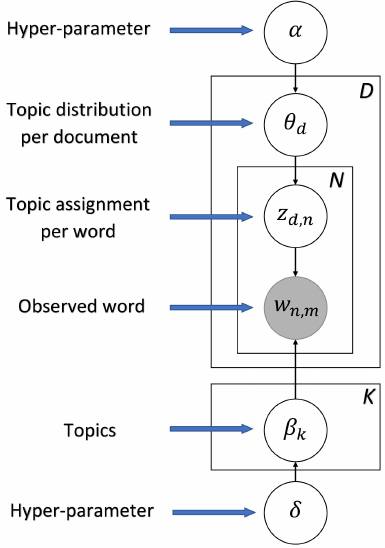
Figure 1. Representation of latent Dirichlet allocation LDA. Hidden nodes are not shaded and represent the proportions of topics, assignments, and